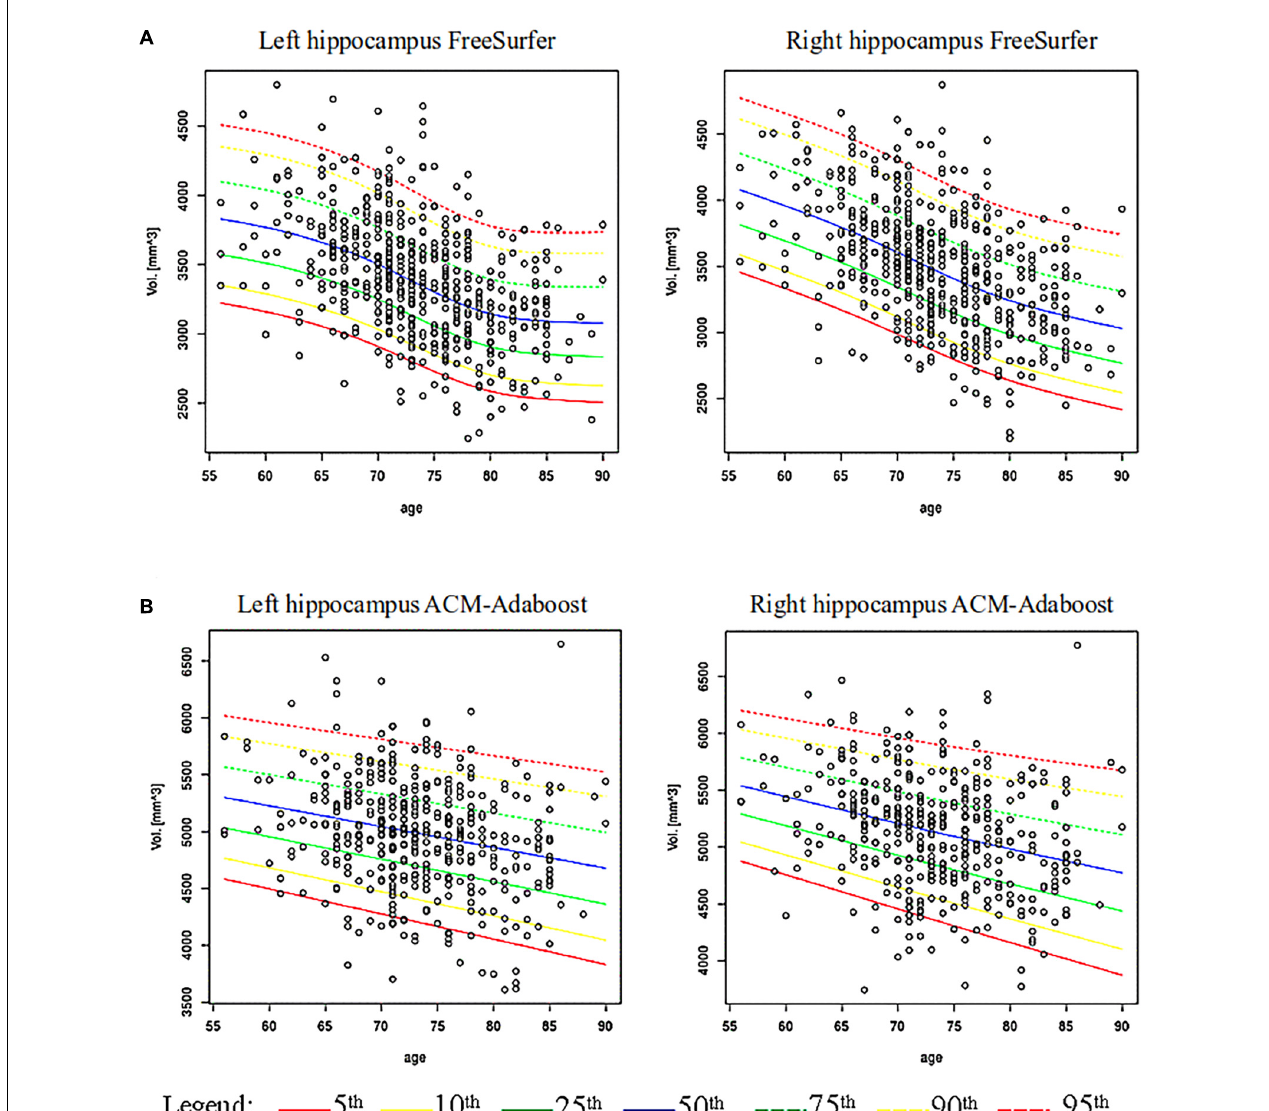
FIGURE 1 | Age-specific percentile distribution of hippocampal volume normalized for total intracranial volume. (A) Shows age-specific distribution of hippocampal volumes computed via FreeSurfer (FS) (532 subjects) and its percentiles fitting a Gamma distribution on ADNI data. (B) Shows the hippocampal volumes computed via ACM-Adaboost (AA) (421 subjects) fitting a Logistic distribution on ADNI